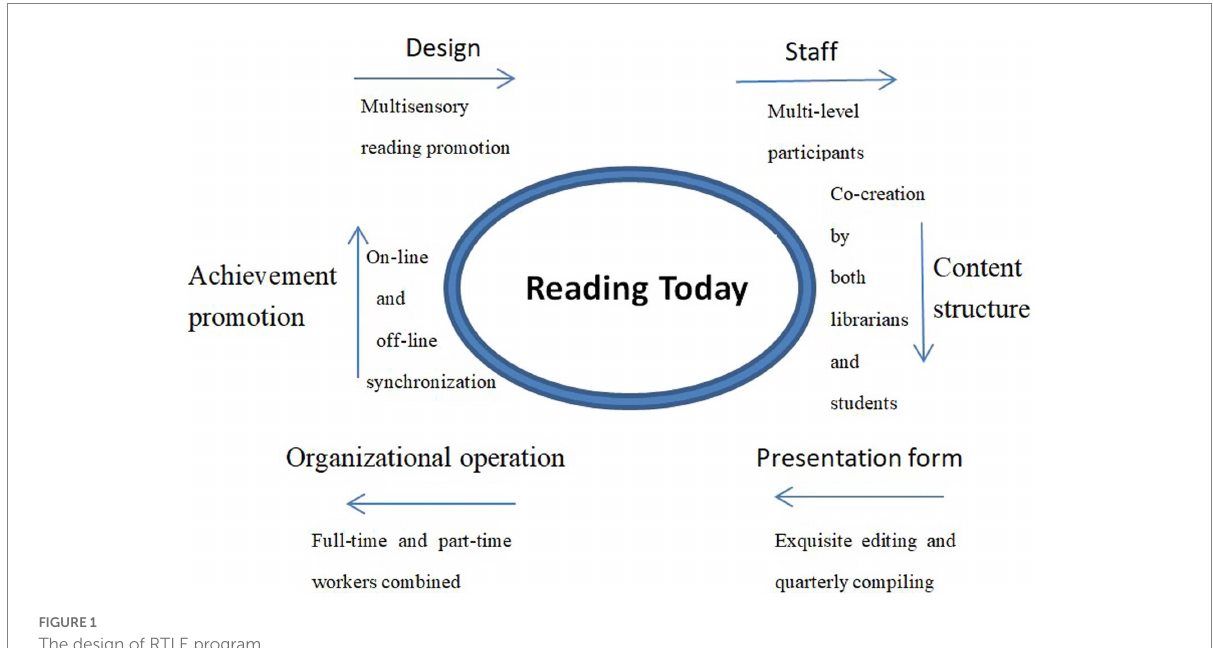
FIGURE 1 The design of RTLE